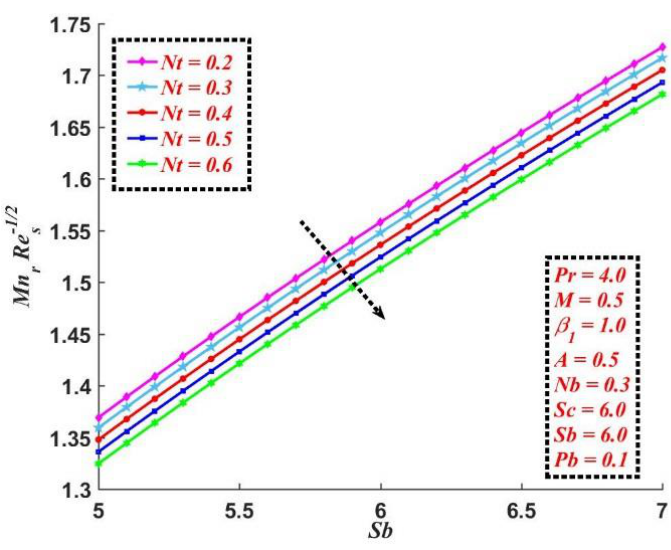
Figure 14. Variation of the motile microorganisms’ number with 𝑁𝑡 and 𝑆𝑏 .